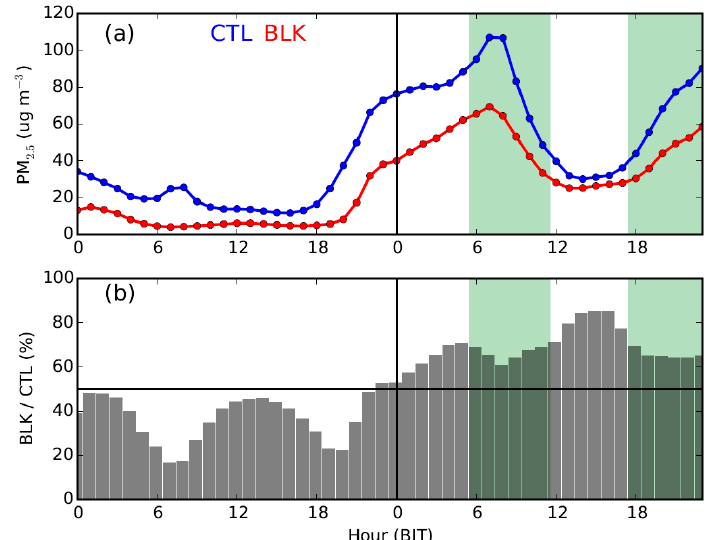
Figure 10. ( a ) Time series of near-surface PM 2.5 concentrations in Beijing derived from the CTL run (in blue), and those contributed by the anthropogenic emissions outside Beijing (i.e., the BLK run, in red), and ( b ) relative contribution of PM 2.5 concentration (BLK/CTL) from external regions. The simulations presented here are derived from the urban areas of the ROI denoted by the blue square in Figure 1b. The green shaded areas indicate the approximate periods when the PBL over Beijing is influenced by the LLJ above.